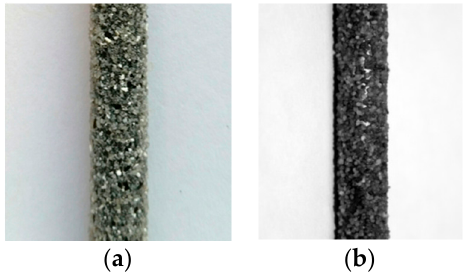
Figure 1. ( a ) Novel sand coated ultra-high modulus (UHM) pitch-based carbon fibre reinforced polymer (CFRP) and ( b ) conventional polyacrylonitrile (PAN)-based CFRP tendon.